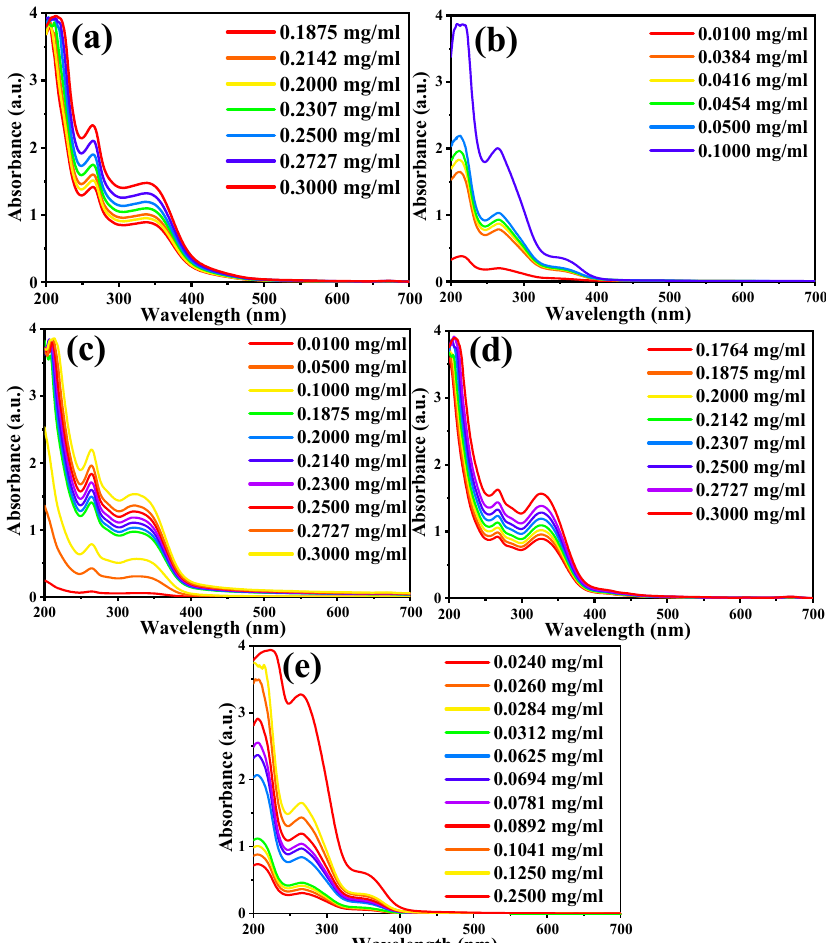
Figure 4. UV-Vis absorbance curve of the plant extracts at the different indicated concentrations: ( a ) Senna alexandrina , ( b ) Myrtus communis L. (Leaf), ( c ) Silybum marianum L. (Flower), ( d ) Silybum marianum L. (Leaf), and ( e ) Rosa moschata L. (Flower). Table 3. Comparison of total polyphenol content (TPC) in different plants by Orange Data Mining Tool (ODMT) and Folin–Ciocalteu method (FC) used as the reference method. Data are expressed in terms of the gallic acid equivalent (GAE) in mg/g dry weight (DW) of the plant extract. TPC (mg GAE/g Samples